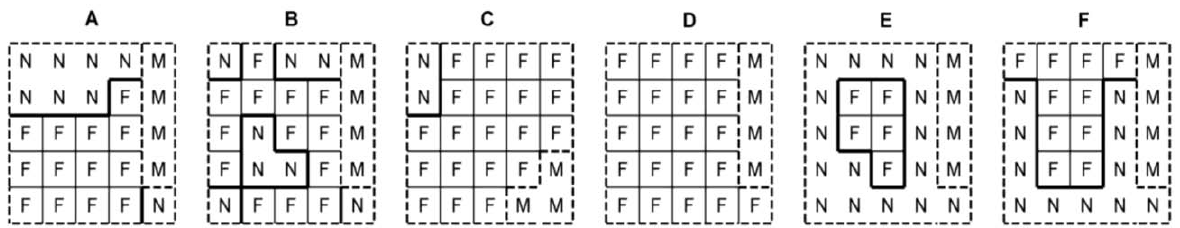
Fig. 4. Illustration of measurement identification: edge (A), perforated (B), undetermined (C), interior (D), patch (E), and transitional (F) fragmentation components within six blocks. Whereas “ F ” – forest, “ N ” – non-forest and “ M ” – missing pixels. Heavy solid lines indicate { FN } connection, light solid lines – { FF }, no lines – { NN }, { MM } pixel edge types. { NN }, { MM } and dashed lines are not used in